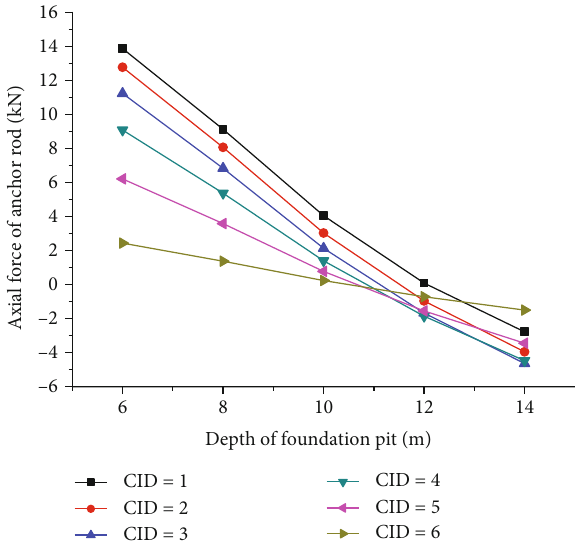
Figure 11: Variation curve of axial force of each component of anchor bolt at the top of tunnel under 10 m deep foundation pit with the width of foundation pit.